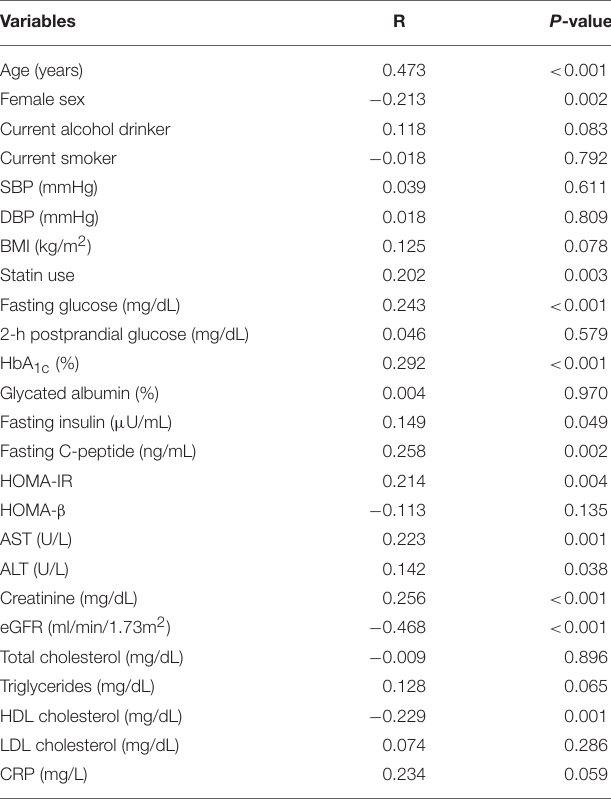
TABLE 2 | Correlation between serum netrin-1 concentration and glycometabolic parameters.